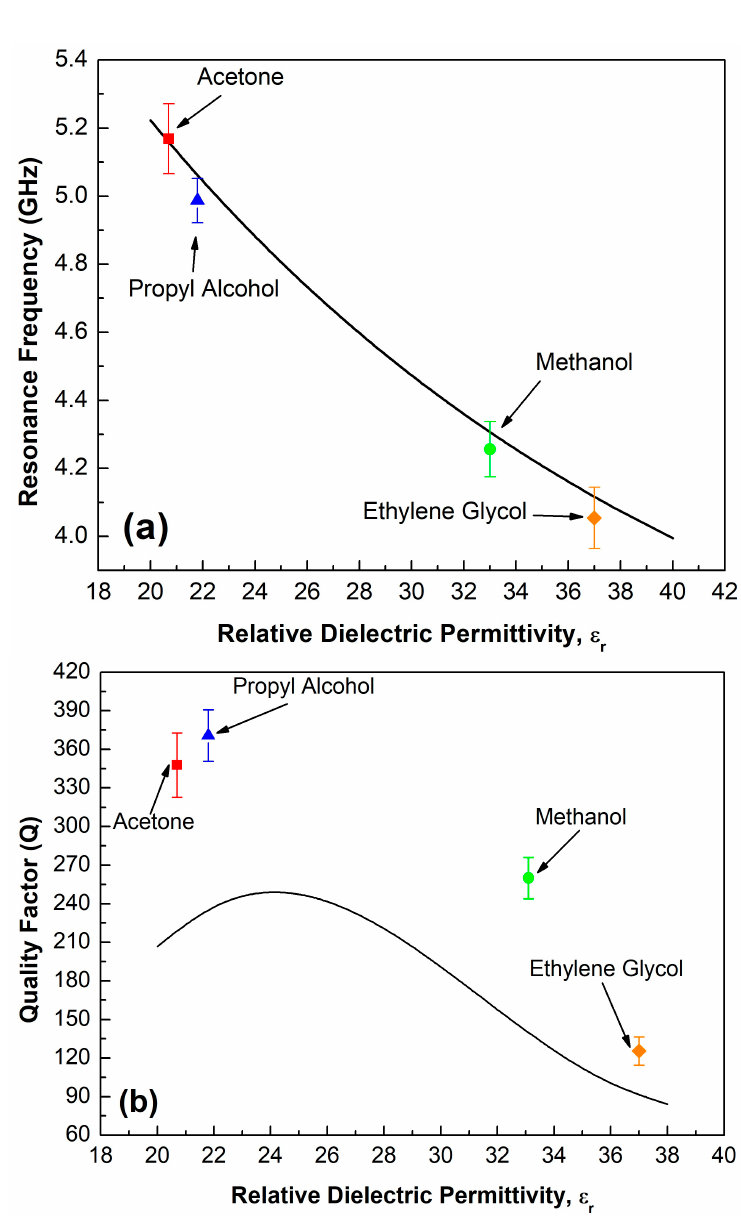
Figure 4. ( a ) Resonance frequency in function of the dielectric permittivity of different liquids. ( b ) Quality factor analysis of the proposed sensor within the operating range. The point in the plot are the mean value of the resonance frequency and the bars are representative of the standard deviation.